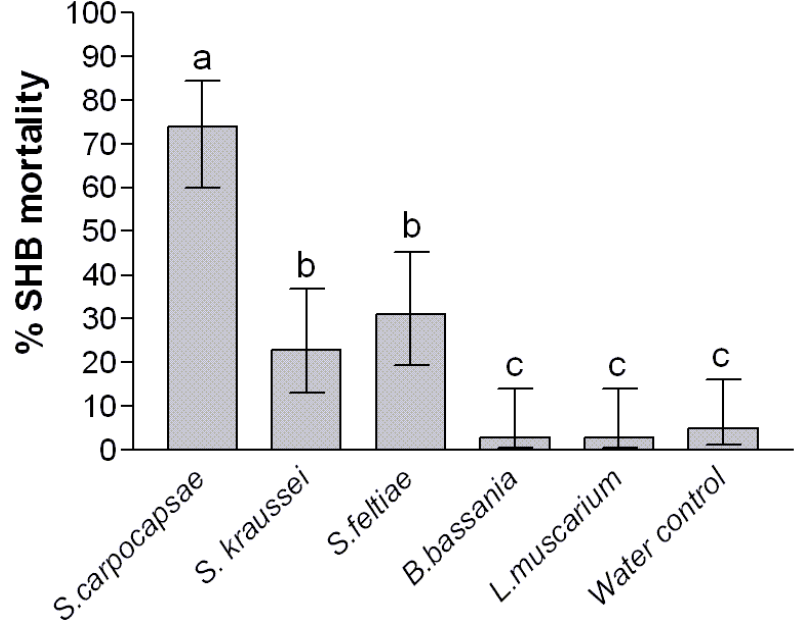
Figure 1. Impact of direct exposure of control agents on Aethina tumida wandering larvae after 2 weeks. Error bars represent the 95% confidence intervals. Means were separated using least significant differences after adjusting for multiple comparisons. Significantly different means (5% significant level) are represented by suffixes a (cid:177) c.